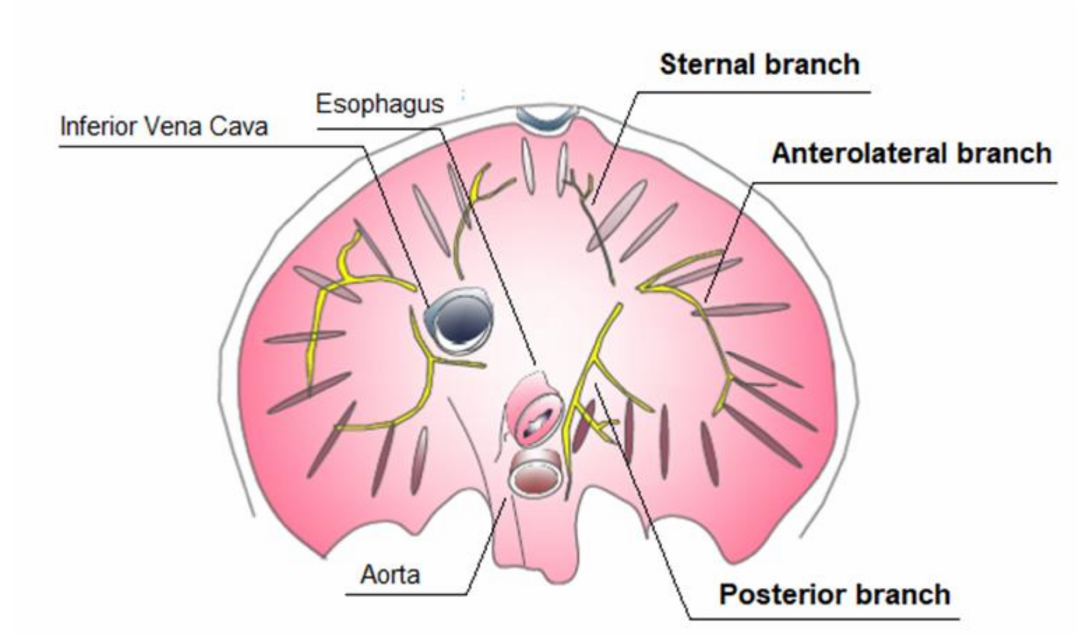
Figure 1. Inferior view of diaphragm: intramuscular distribution of the phrenic nerve. The presence of an accessory phrenic nerve arising from the fifth or fifth and sixth cervical nerves has been noted [21].